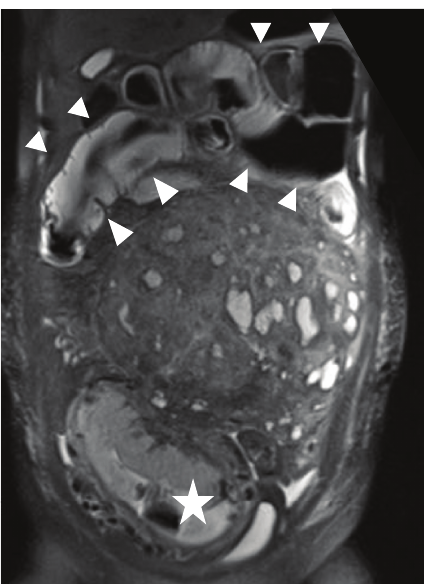
Figure 1: Magnetic resonance imaging of this patient at 12 6/7 weeks of gestation. Coronal T2-weighted image shows the uterus (star). A large myoma and a dilated intestinal tract (arrowhead) are